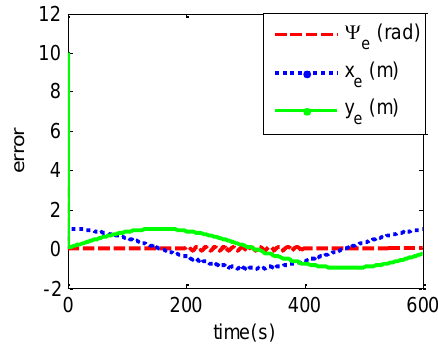
Figure 10. Position and orientation errors of AUVs using the FFTC method.